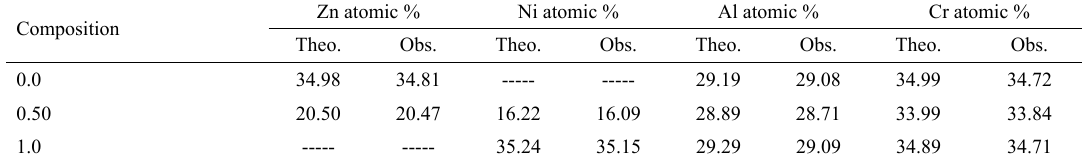
Ni AlCrO (x = 0.0, 0.50, 1.0) 1-x x 4